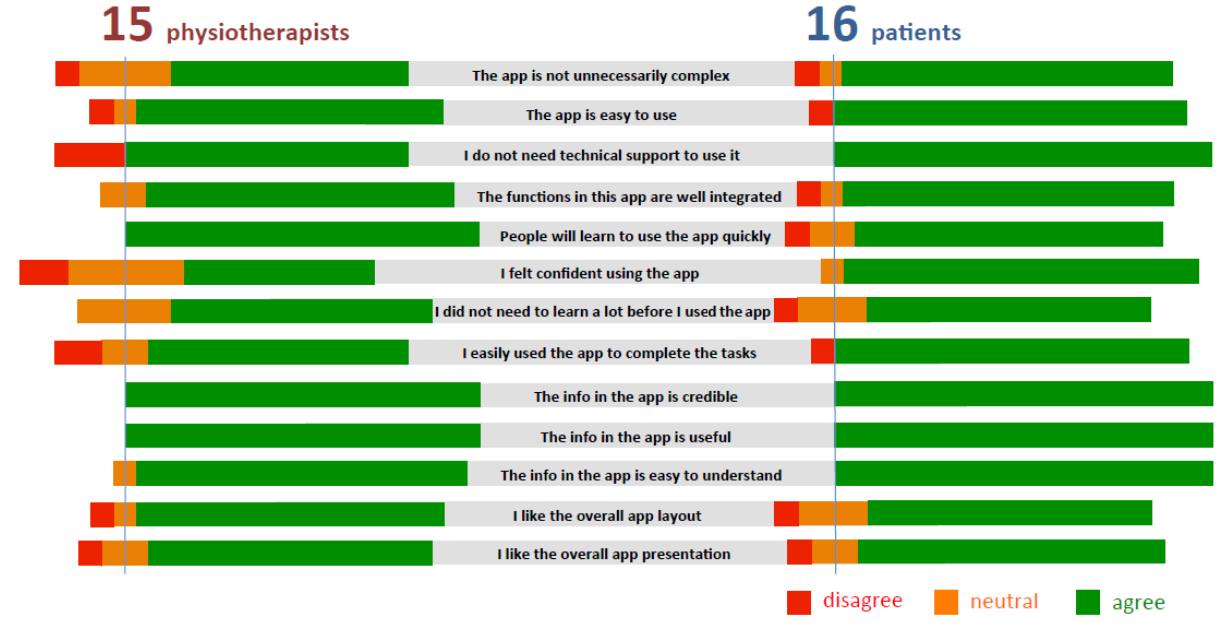
Figure 8. A summary of responses about user perception.